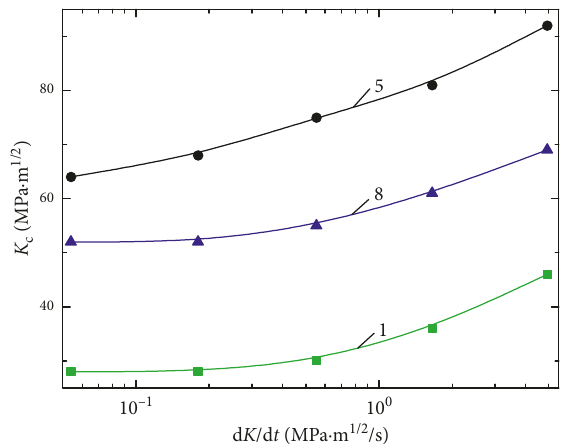
Figure 2: Dependences of fracture toughness K c genated (623 K, 30MPa H 2 , 10h) specimens of 20mm thickness on the hydrogen pressure P at a strain rate of 0.1mm/min. The numbers near curves correspond to ordinal numbers in Table